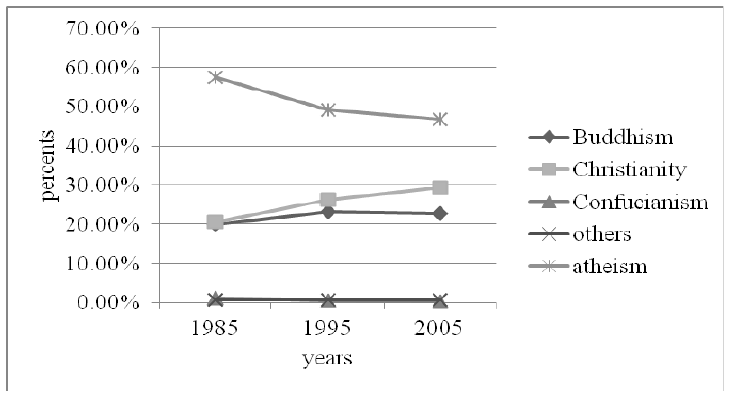
Figure 1. Ratio of religious Koreans. Notes: Source